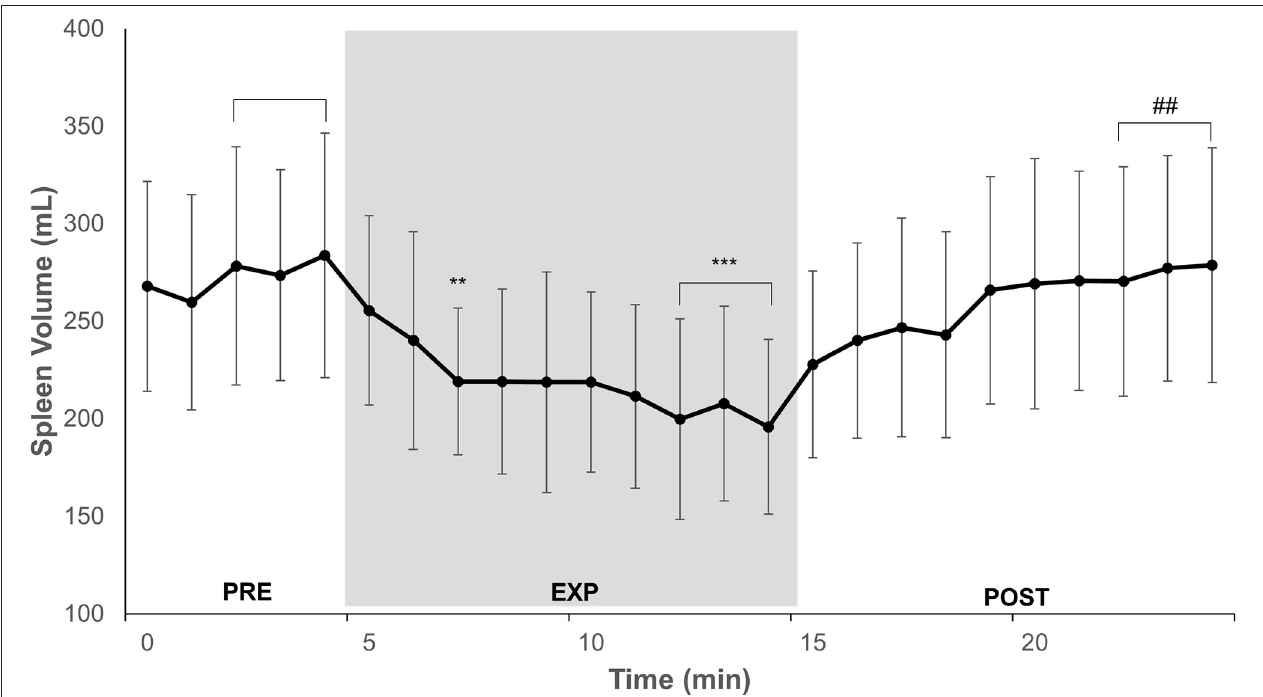
FIGURE 2 | Minute-to-minute mean and SD of spleen volume during 5min normoxic breathing (PRE), 10min hypoxic breathing of 10% O 2 (EXP), and 10min hyperoxic breathing of 100% O 2 (POST) for n = 14. Gray zone indicates EXP. Horizontal brackets indicate an averaged value for that period. Significant difference from PRE is indicated by ** for P < 0.01 and *** for P < 0.001. Significant difference from EXP is indicated by ## for P <